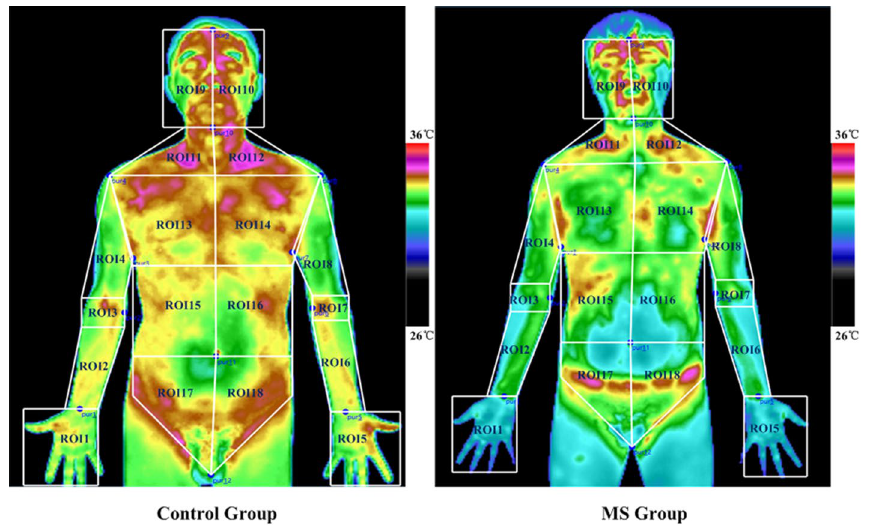
Figure 5. ROI segmentation results of the IRT data.